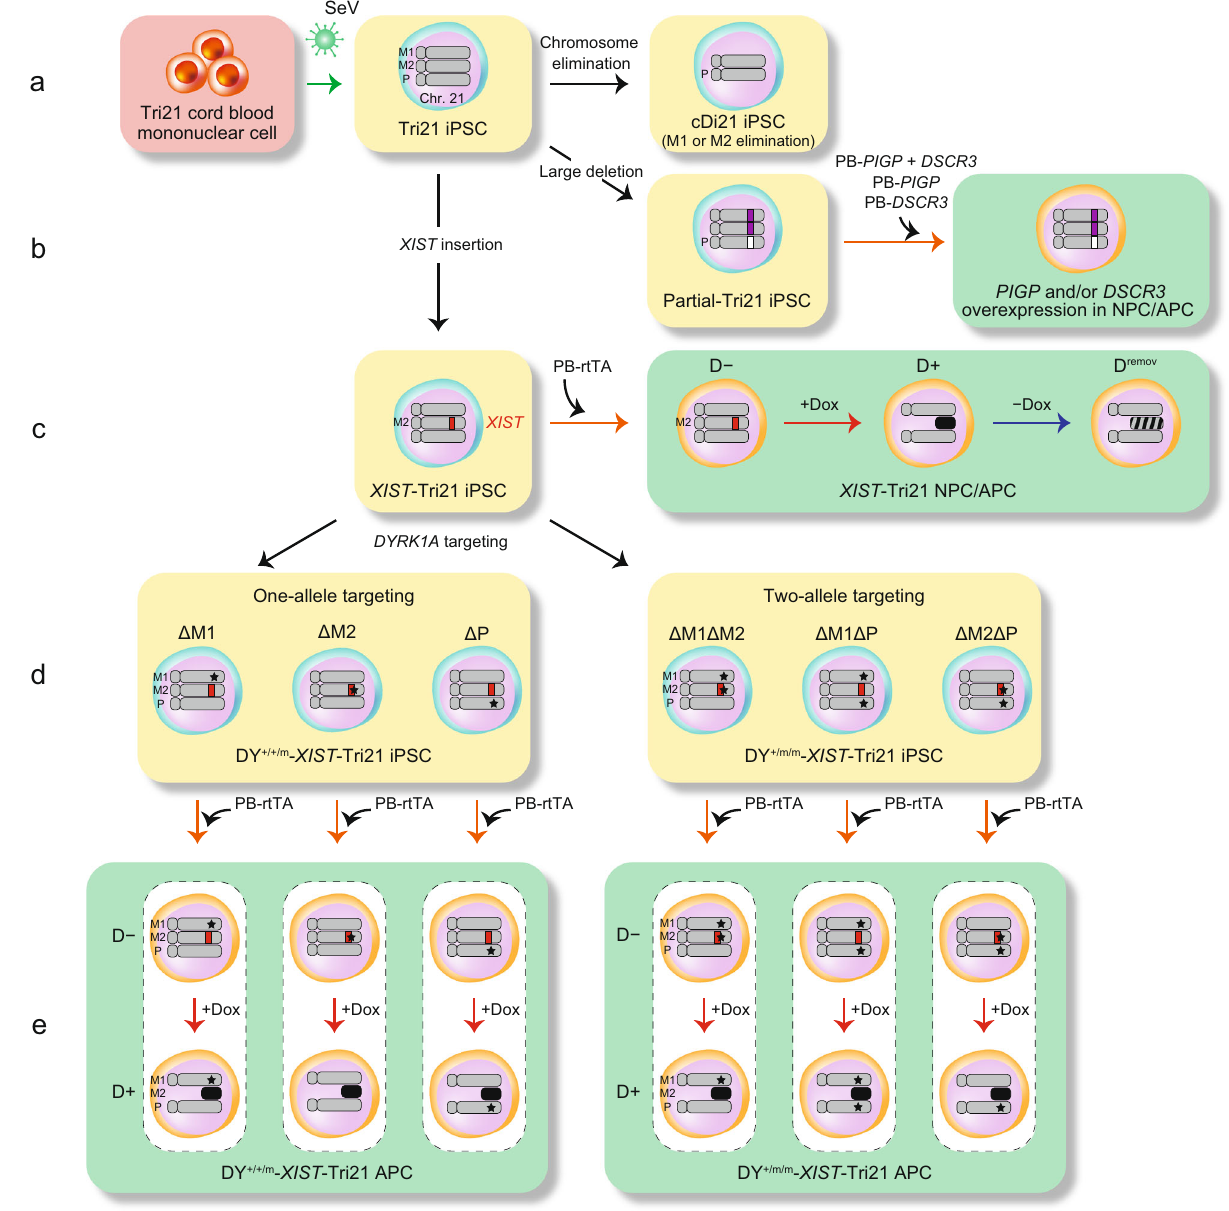
Fig. 1 Generation of an isogenic iPSC panel for disease modelling of DS. Schematic overview depicting the strategy used to generate isogenic iPSC lines by combining XIST -induced chromosome silencing and genome/chromosome-editing technologies. a Cord blood mononuclear cells were derived from a male patient with DS. Then, a DS-speci fi c iPSC line (Tri21) was directly established using Sendai virus. A corrected-disomy cell line (cDi21) was generated by eliminating a single copy of chromosome 21 from a Tri21 iPSC line. b A 4-Mb region corresponding to a ‘ Down syndrome critical region ’ was selectively deleted only from the paternal chromosome 21 in Tri21 iPSCs to generate Partial-Tri21 iPSC. NPCs differentiated from Partial-Tri21 iPSCs were transfected with piggyBac (PB) transposon vectors containing human PIGP and/or DSCR3 cDNA under the regulation of the Tet-inducible system. NPCs were differentiated into APCs for further analysis. c Dox-inducible human XIST cDNA was inserted into one copy of chromosome 21 in Tri21 iPSCs ( XIST -Tri21 iPSC) for chromosome silencing. rtTA was additionally introduced into NPCs differentiated from XIST -Tri21 iPSCs, using a PB vector. Transcriptional and phenotypic analysis was conducted in Dox-untreated (D − ) and Dox-treated (D + ) cells, and in NPCs or APCs at 3 weeks after Dox removal (D remov ). The location of the XIST transgene is indicated by the red rectangle. The black and striped chromosomes indicate a silenced and a reverted chromosome 21, respectively. d The DYRK1A gene was targeted in one or two chromosomes in the XIST -Tri21 iPSC line to generate DY + / + /m - and DY + /m/m - XIST -Tri21 iPSCs, respectively. Three types of genome-edited cell lines were generated in each single- or double-targeted clone, based on the parental origin of the three chromosomes. Black stars indicate the DYRK1A target sites. Two maternal copies and one paternal copy of chromosome 21 are indicated as M1/M2 and P, respectively. e DYRK1A -targeted iPSC lines were differentiated to APCs and subjected to phenotypic analysis. Light yellow panels and light green panels indicate iPSC lines and NPC/APC lines,